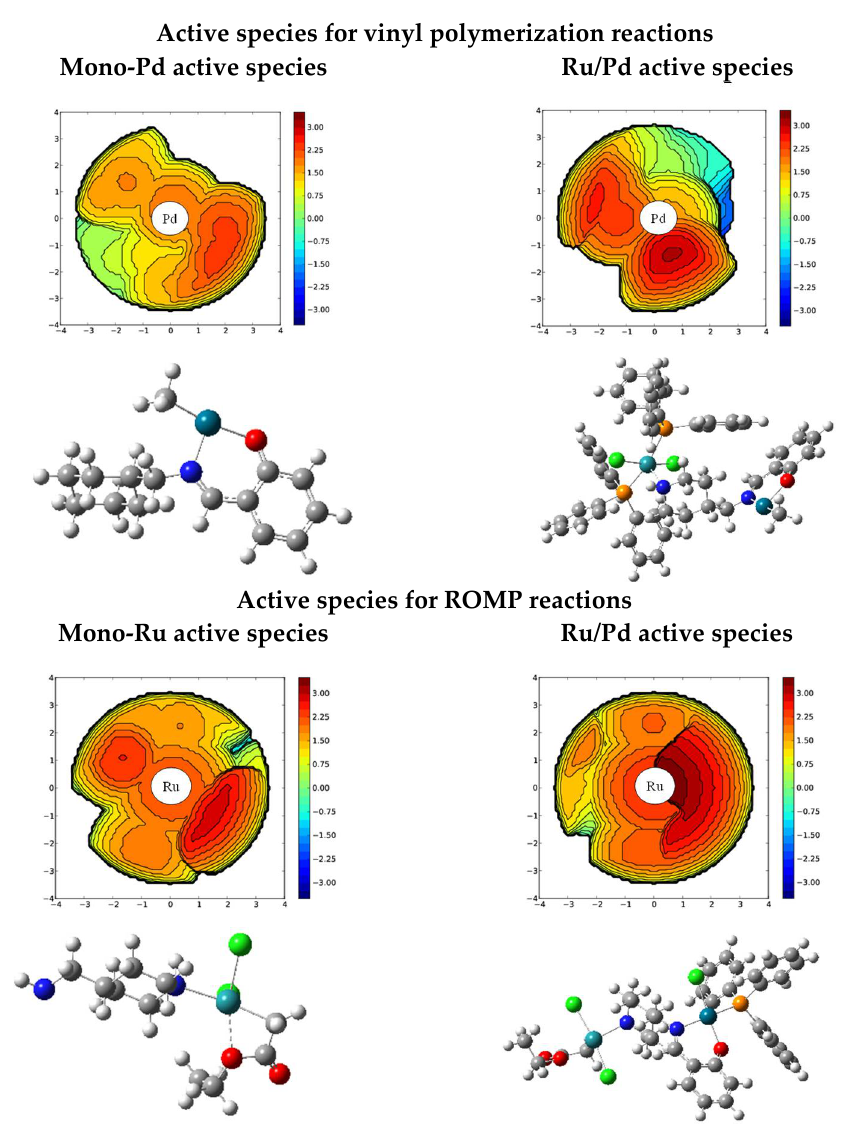
Figure 6. Topographic steric maps of active species in vinyl polymerization and ROMP reactions and their respective optimized structures. Active species of mono-Pd and mono-Ru ( left ) and active species of Ru/Pd ( right ). The iso-contour curves are in Å .